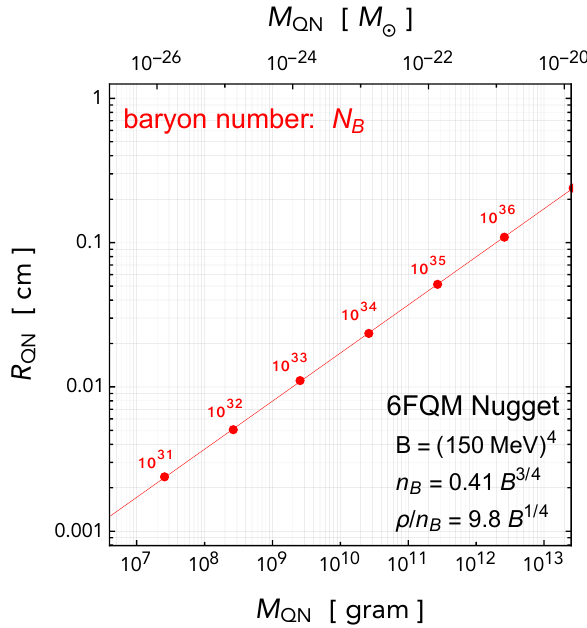
Figure 3 . The mass and radius of a nugget of 6FQM, given by eqs. (3.5) and (3.6), for various values of its total baryon number (shown in